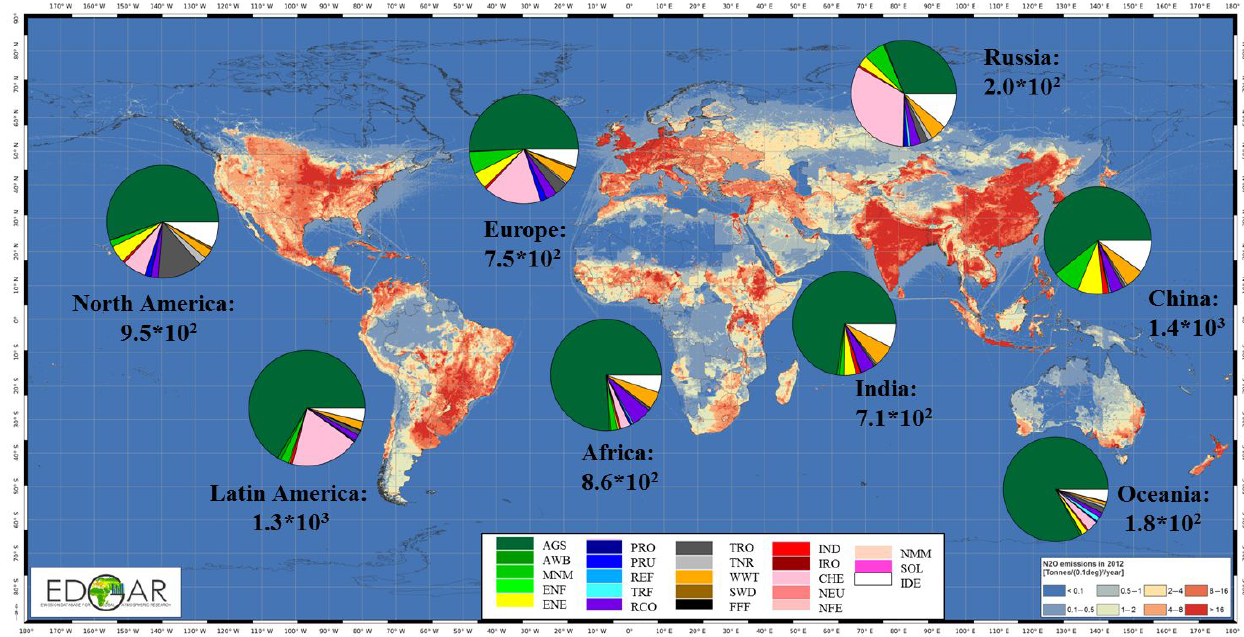
Figure 15. N 2 O emission grid map and relative contribution of EDGAR sectors in world regions (pie charts) for 2012. The legend for the PIE charts relates to the EDGAR sectors, defined in Table S3: AGS: agricultural soils, AWB: agricultural waste burning, MNM: manure management, ENF: enteric fermentation, ENE: power industry, PRO: fuel production, PRU: production and use of products, REF: oil refiner- ies, TRF: transformation industry, RCO: residential, TRO: road transport, TNR: non-road transport, WWT: waste water, SWD: solid waste disposal, FFF: fossil fuel fires, IND: manufacturing industry, IRO: iron and steel, CHE: chemicals, NEU: non-energy use, NFE: non-ferrous metals, NMM: non-metallic minerals, SOL: solvents, IDE: indirect emissions.